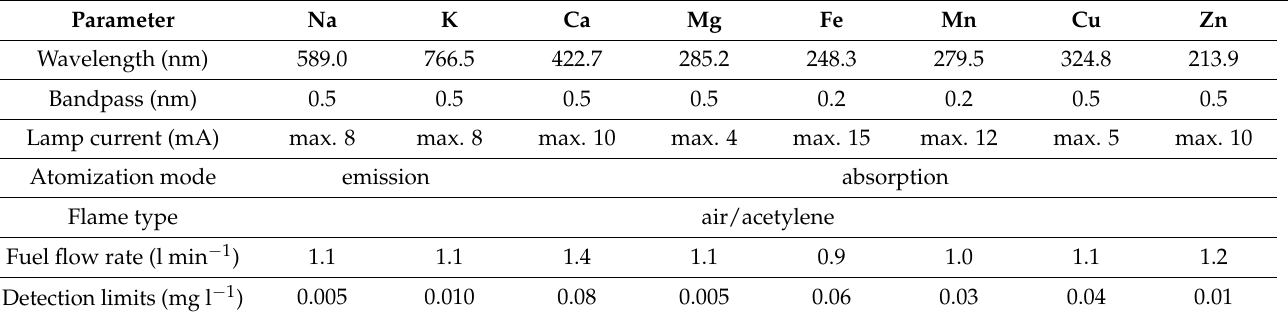
Table 1. AAS instrumental